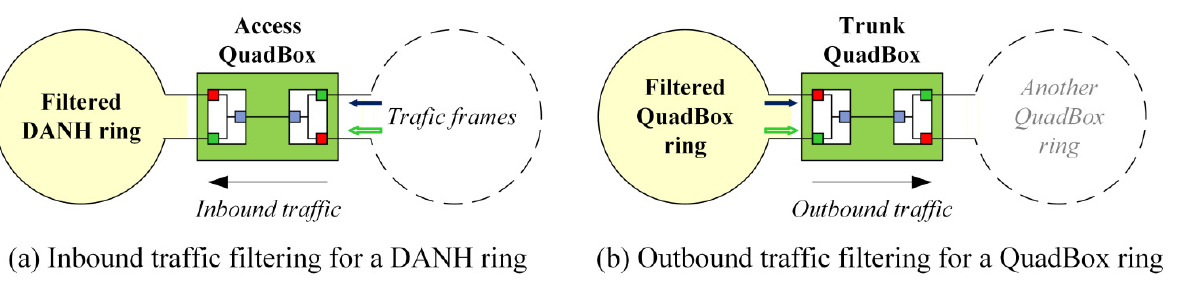
Figure 10. The process of filtering unicast